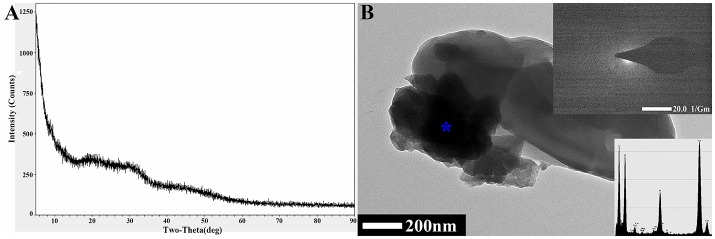
The detection and analysis of biogenic CaCO3 by XRD and TEM-SAED. (A) XRD detection. (B) TEM-SAED analysis. The “*” in the figure is the site of the EDS analysis.